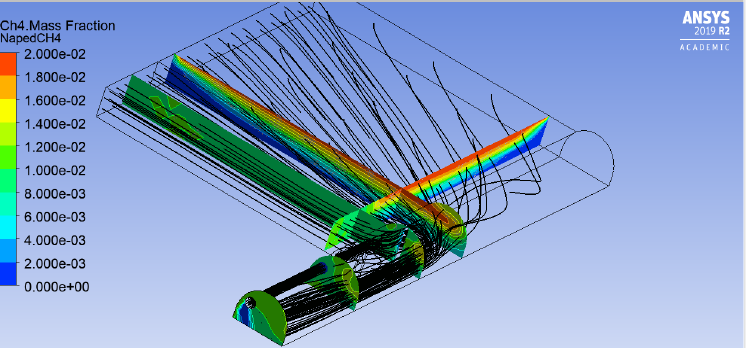
Figure 5. Model of the distribution of methane concentrations at the longwall and tailgate crossing based on parameters obtained as a result of in situ